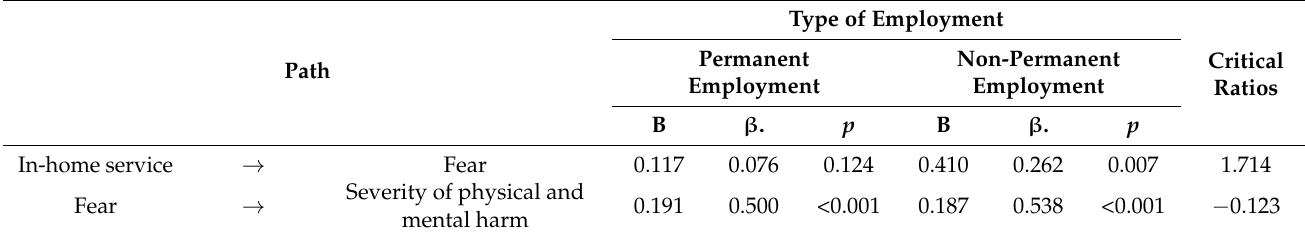
Table 5. Results of path analysis according to type of